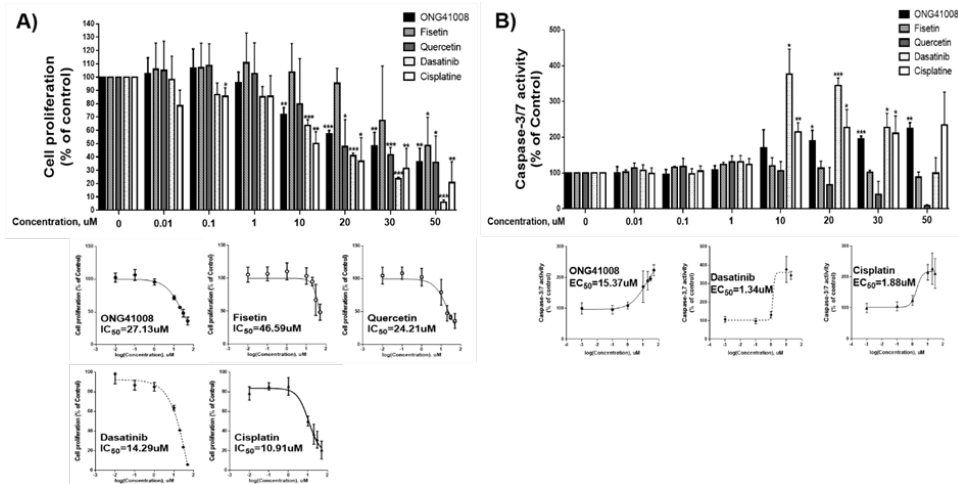
Figure 7. Comparison of senolytic capabilities. ( A ) PANC1 cells were treated with increasing con- centrations (from 100 nM to 50 μM) of ONG41008, quercetin, fisetin, dasatinib, or cisplatin. CCK -8 assays were conducted, and IC50 values were calculated. ( B ) PANC1 cells were stimulated as de- scribed above and Caspase-3 and -7 assays were conducted. EC50 values were also calculated. Three